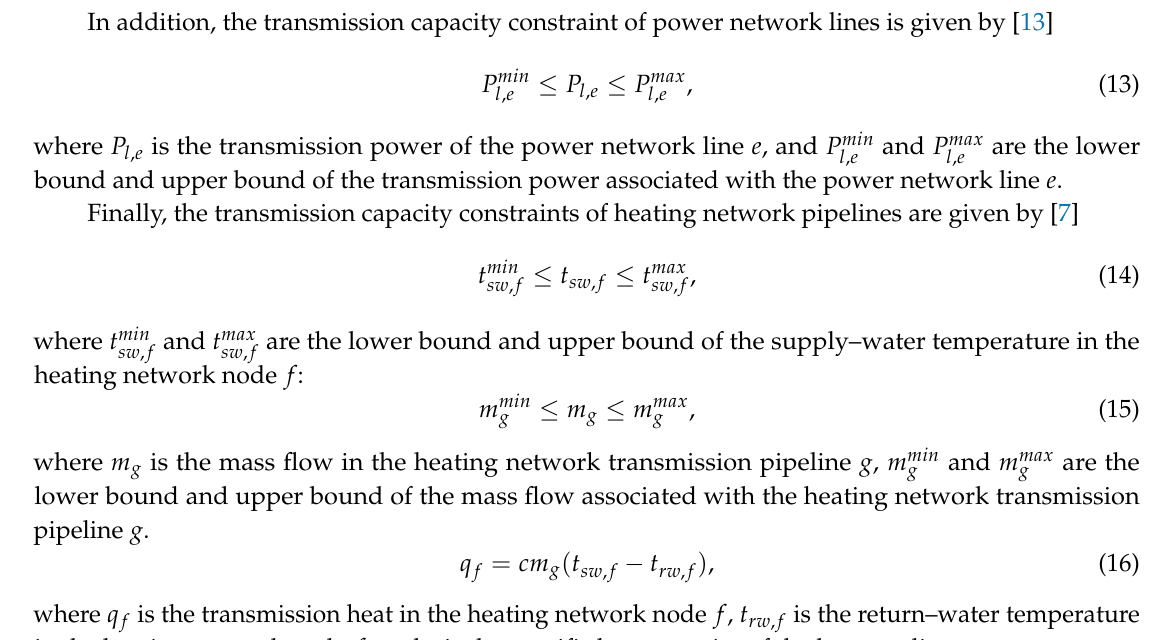
Figure 2. The heat-power feasible operation region of CHP